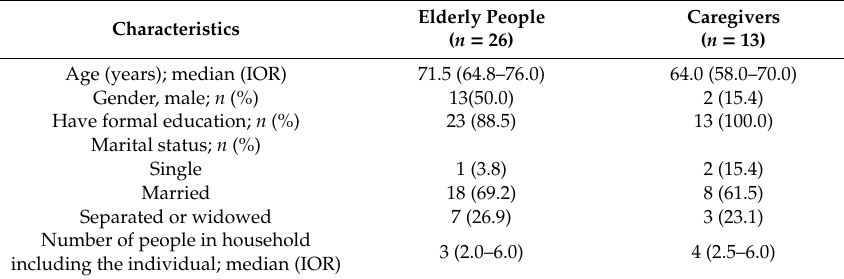
Table 2. Sociodemographic data of the study